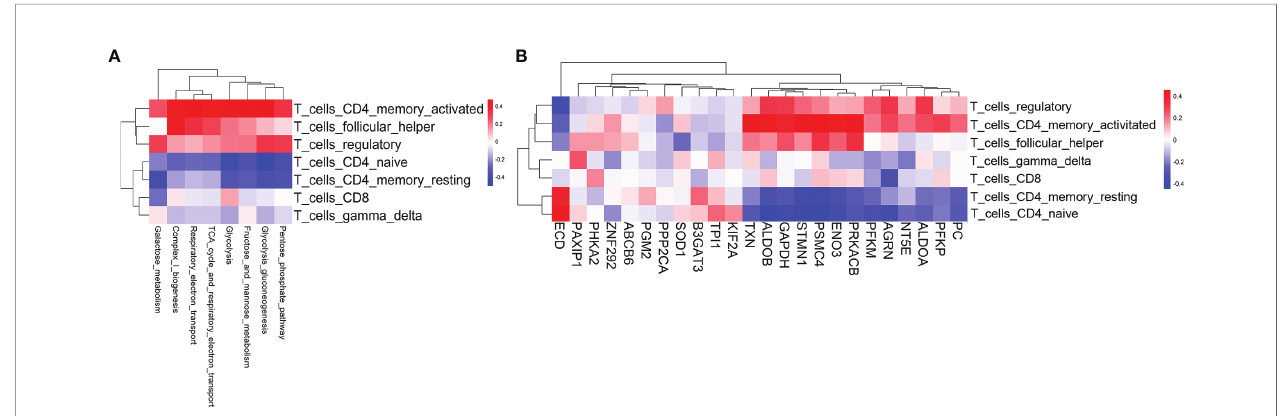
FIGURE 3 | T-cell subsets associated with glycolysis-related pathways and glycolytic genes. (A) Heatmap of the Pearson correlation coef fi cients between glycolysis- related metabolic signatures and T-cell subset signatures. (B) Heatmap of the Pearson correlation coef fi cients between glycolytic genes and T-cell subset signatures. The information for the T-cell subsets was obtained